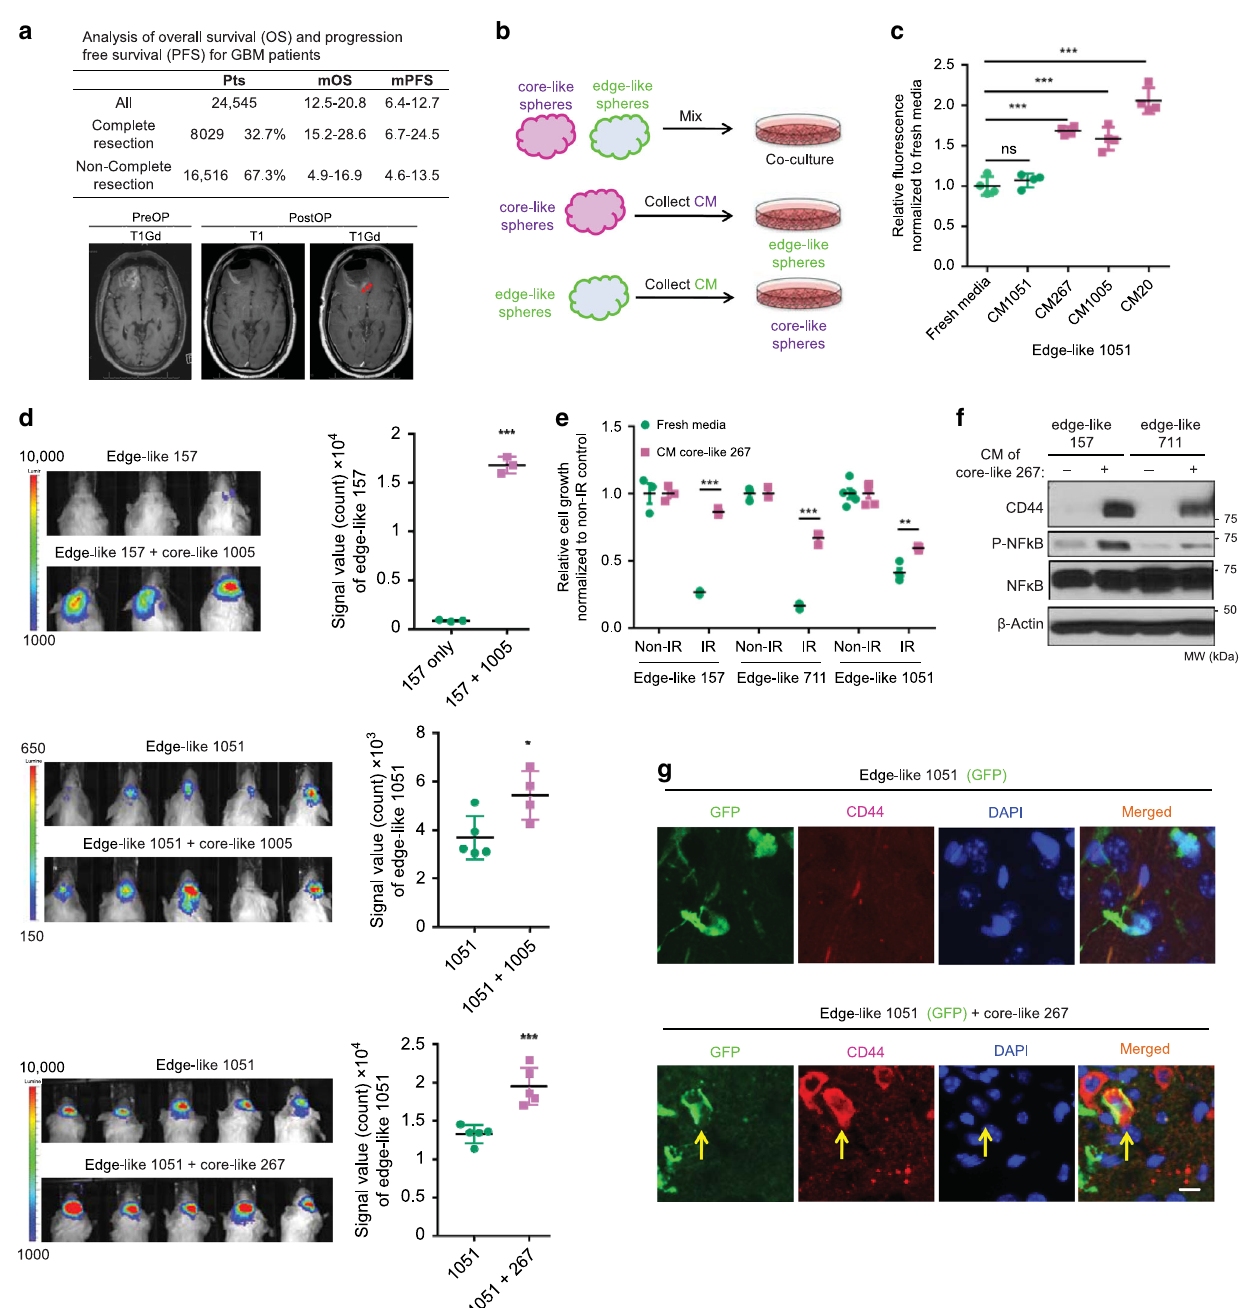
Fig. 3 Intercellular signaling from core-like GBM cells provokes aggressiveness of their edge-like counterparts. a Table comparing overall survival (OS) and progression free survival (PFS) of GBM patients that underwent complete or non-complete resection (upper). The representative MRI image of pre- and postoperative brain, demonstrating residual enhancing lesions after surgery (lower). b Schema of the in vitro experiments with conditioned medium (CM). c In vitro cell growth assay of edge-like 1051 GBM spheres treated with/without CM from edge-like 1051 or core-like 267/1005/20 GBM spheres. Data are mean ± s.d., n = 4 independent samples per group.; ns, not signi fi cant; ** p < 0.001 using one-way ANOVA followed by Tukey ’ s post-test. d Bioluminescence imaging (BLI) of mice intracranially injected with luciferase-labeled 1051 ( n = 5 animals) or 157 ( n = 3 animals) edge-like GBM spheres alone or together with unlabeled core-like GBM spheres (267, 1005) (ratio 95:5) (left). Quanti fi cation of BLI signal in mice (right). e In vitro c e ll viability assay of edge-like 157, 711, and 1051 GBM spheres pretreated with CM from core-like 267 GBM spheres and irradiated (IR) or left non-irradiated (non-IR). n = 4 independent samples per group. f Western blot (WB) for p65, phosphorylated p65 (p-p65) and CD44 using edge-like 157/711 GBM spheres treated with or without CM from core-like 267 GBM spheres. g IF staining for nucleus (blue), GFP (green) and CD44 (red) of mice brains bearing intracranial tumors developed from edge-like 1051 GBM spheres (labeled with GFP) alone, or co-injected with core-like 267 GBM spheres (unlabeled). Scale bar 20 µ m. d – e Data are m e an ± s.d. Signi fi cance was calculated by unpaired, two-tailed t -test with * p < 0.05; ** p < 0.01; *** p <